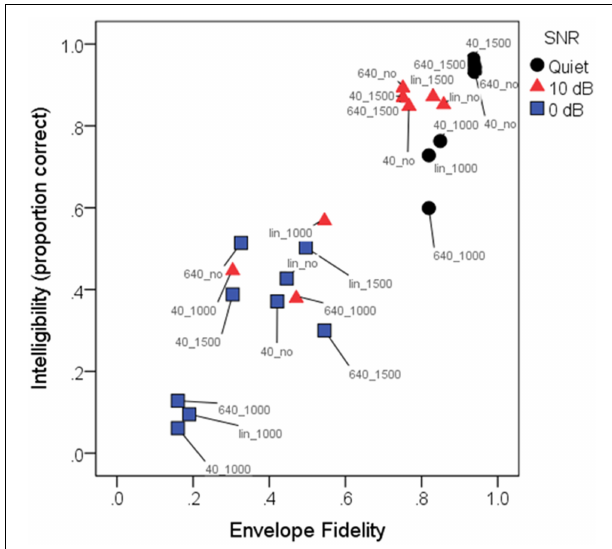
FIGURE 5 | Mean intelligibility scores (in proportion correct) as a function of envelope fidelity. For linearity prior to analysis, the envelope distortion metric was subjected to a sigmoidal transformation. Pearson product-moment correlation was 0.93, indicating that the envelope fidelity metric was a good predictor of intelligibility scores. Each condition is indicated by a color-label combination. Symbols indicate the three SNRs: quiet (black circles); 10dB SNR (red triangles); 0dB (blue squares). Labels indicate the conditions, where 40_, 640_, and lin_ represent WDRC release time or linear amplification, and _1000, _1500, or _no represent frequency compression cutoff frequency or no FC. As quantified by the envelope fidelity metric, the highest-fidelity condition was linear amplification without frequency compression for speech in quiet, and the lowest-fidelity condition was speech at a signal-to-noise ratio of 0dB with a compression release time of 40ms and a frequency compression cutoff of 1000Hz. Note that due to the close